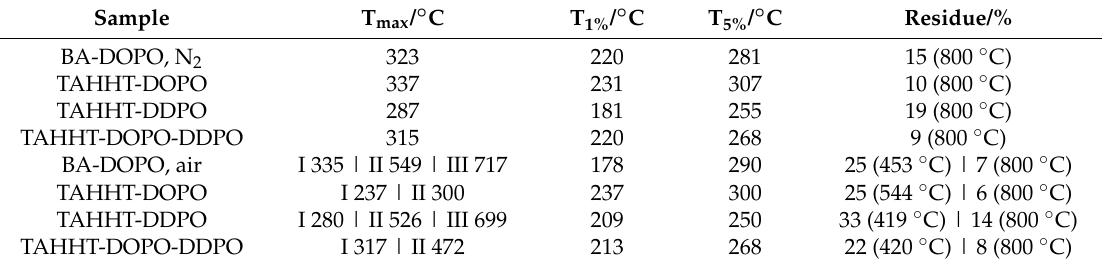
thermogravimetric (TG) measurements in air or under nitrogen atmosphere with a heating rate